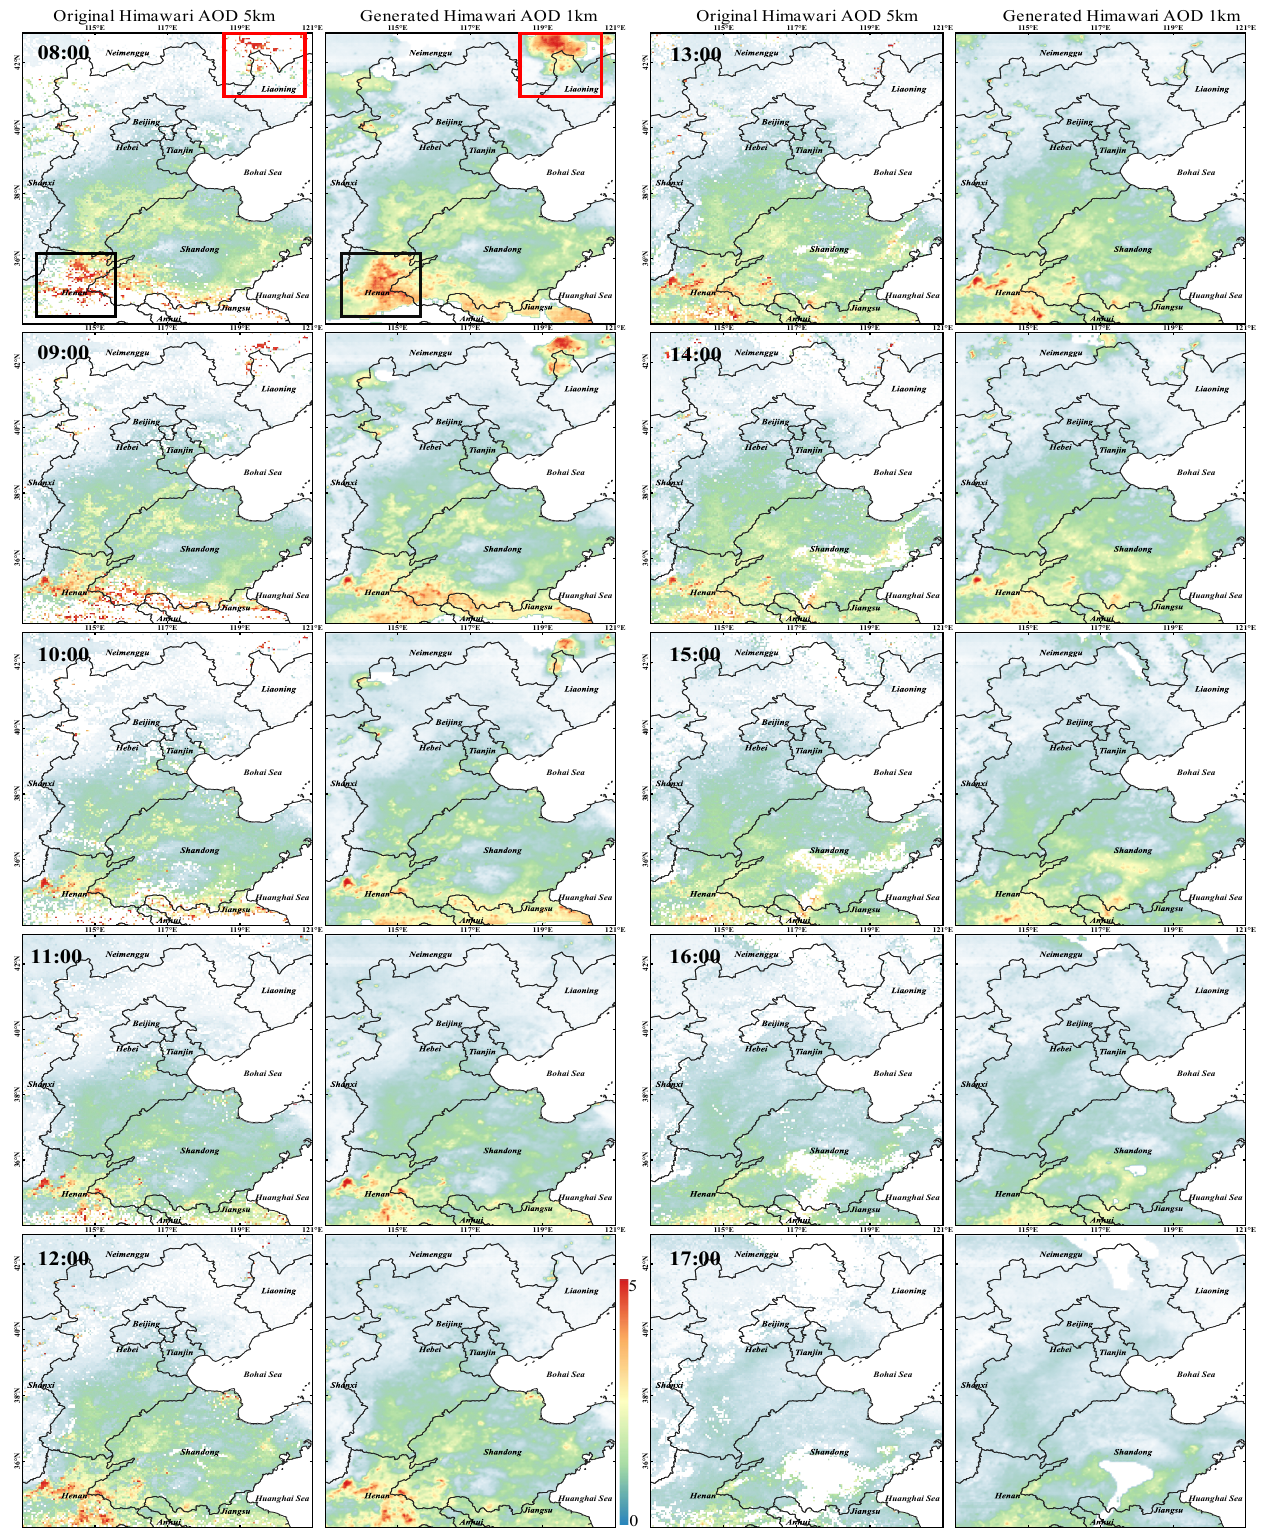
Figure 5. The spatial distribution comparison performance of the original Himawari 5 km AOD and generated Himawari 1 km AOD (1 June 2017, 8:00 a.m. to 5:00 p.m. at Beijing